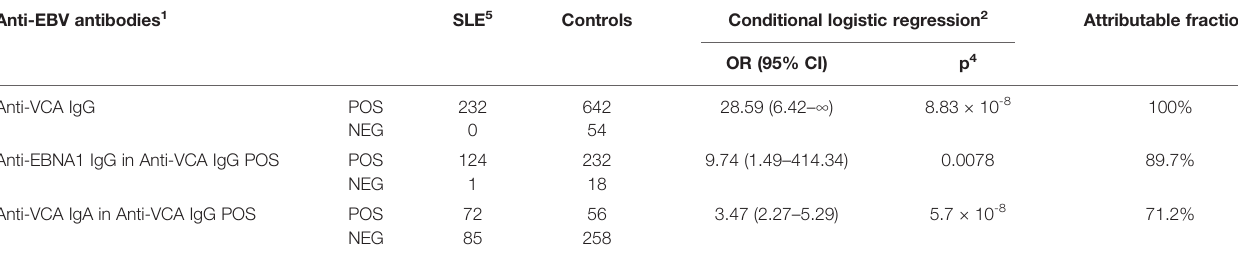
TABLE 1 | Association between SLE status and anti-EBV antibodies in age- and sex-matched cases and controls. Anti-EBV antibodies 1 SLE